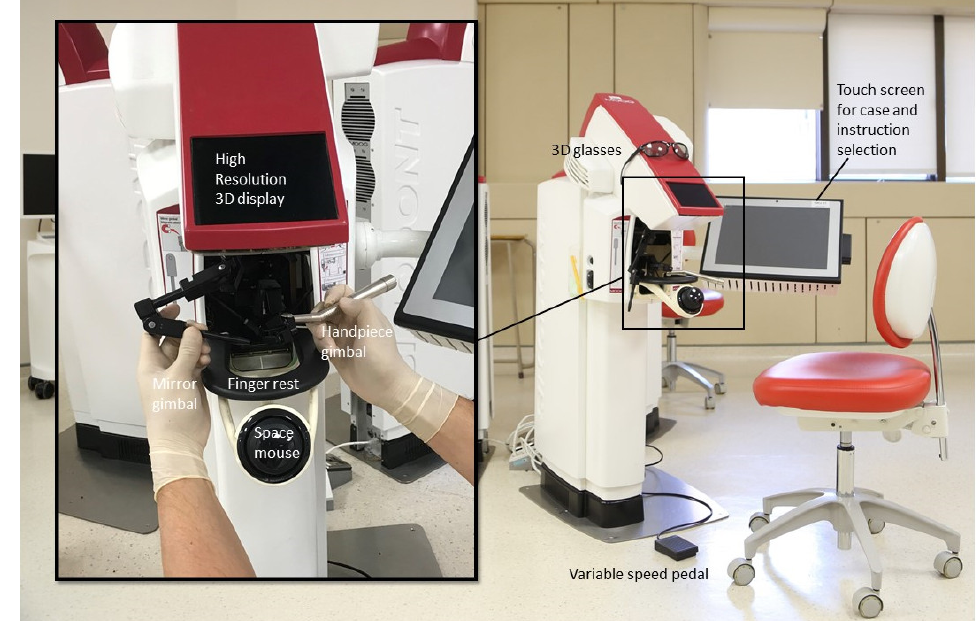
Figure 1. Components of Simodont.